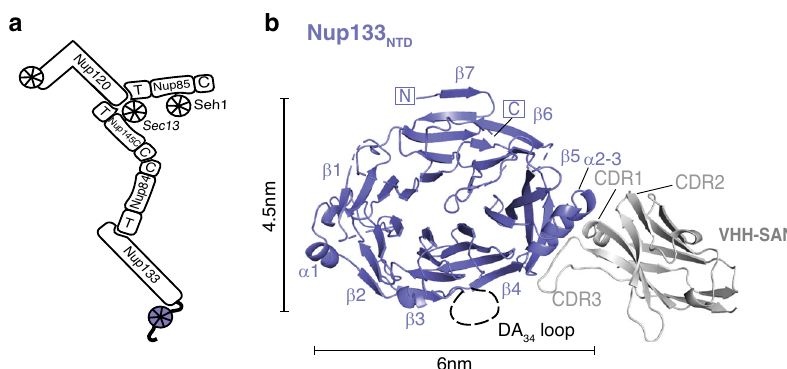
Fig. 4 Structure of Nup133 NTD -VHH-SAN4 complex. a Schematic of the Y complex. The region included in the structure is colored (purple — Nup133). Elements of ACE1 fold proteins are indicated: T — tail and C — crown adjacent to the central trunk element. b Nup133 NTD -VHH-SAN4, with Nup133 NTD in purple and VHH-SAN4 in light gray. N and C termini are indicated, and β -sheets and α -helices are labeled on Nup133 NTD . Complementarity determining region (CDR) loops are labeled on